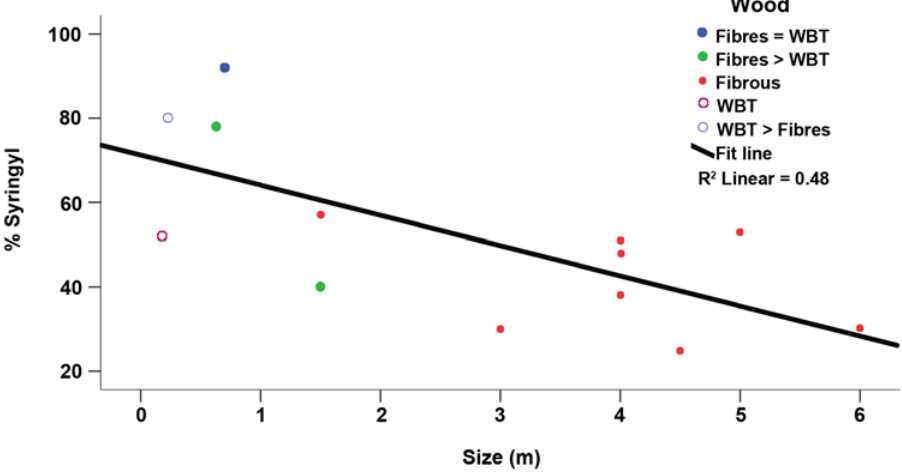
Fig 5. Relationship between plant species size and percentage of syringyl lignin. Each dot represents the species size given in S2 Table.